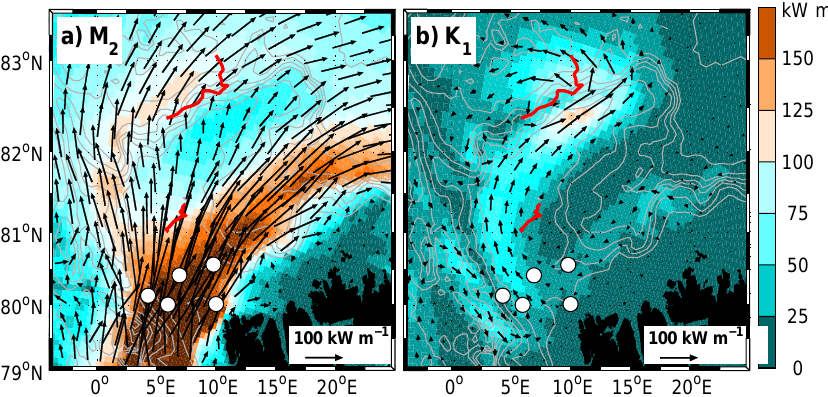
Figure 5. Barotropic tidal flux obtained from STORMTIDE for the (a) M 2 and (b) K 1 constituents. Isobaths (grey) are drawn at 500m intervals from the model topography. The colour is the amplitude of the corresponding flux with colour bar on the right. Every fourth vector is shown with scale indicated. Station positions (open circles), and the drift of CEAREX-O (Padman and Dillon, 1991) (red line over the northern flank) and MIZEX83 (D’Asaro and Morison, 1992) (red line over the plateau) are shown for reference.